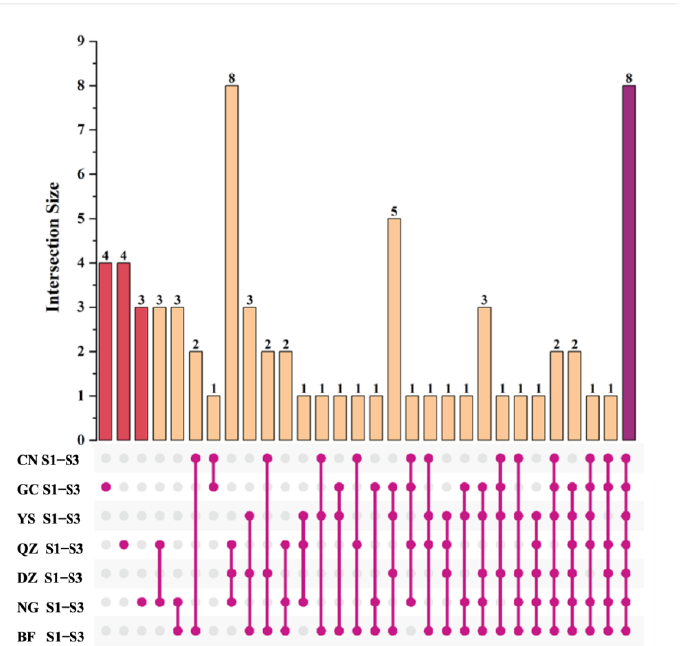
Figure 4. Upset plots of volatiles during three ripening periods for seven green plum varieties. His- togram: Red indicates the amount of unique volatile substances in GC, QZ, and NG green plums; purple indicates the amount of volatile substances in common among the 7 green plum samples; yellow indicates the amount of volatile substances in common among the 2/3/4/5/6 green plum sam- ples.